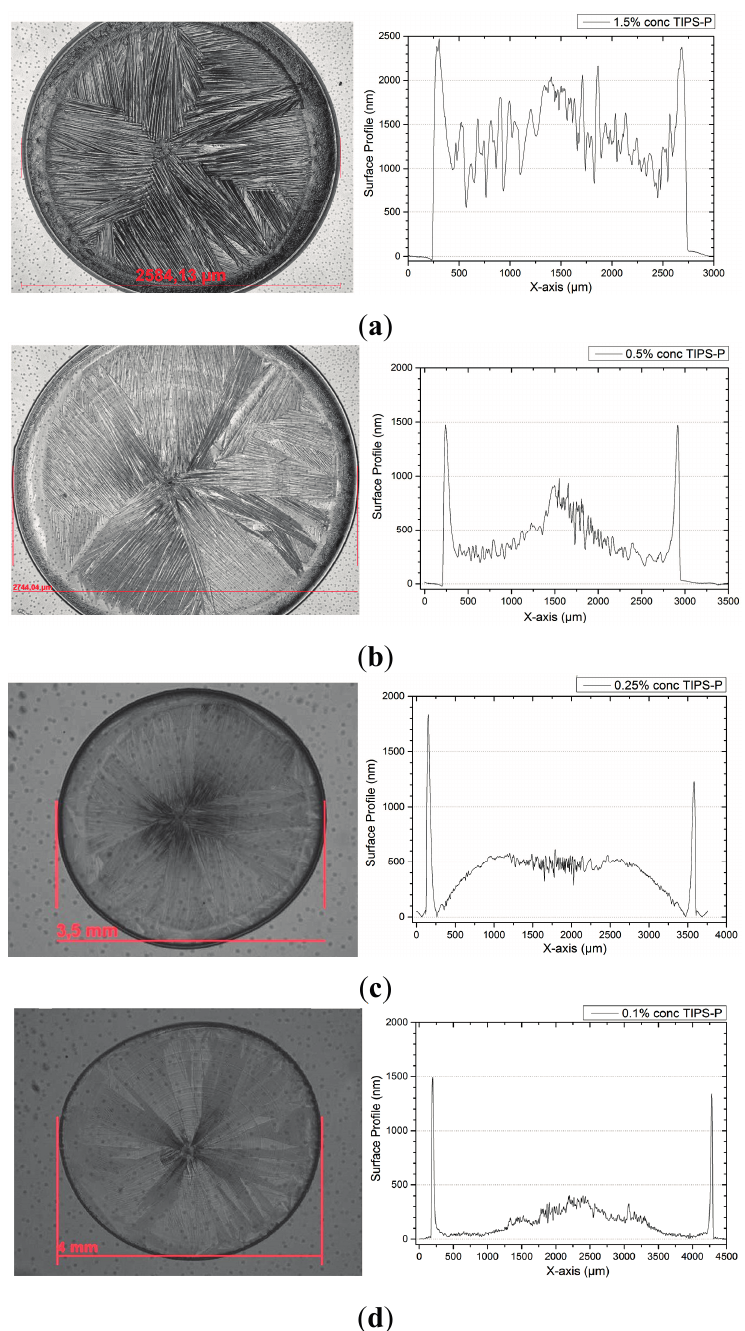
Figure 10. Microscope images of the drops and their corresponding profilometry results with the conc. of TIPS-pentacene varying from ( a ) 1.5%, ( b ) 0.5%, ( c ) 0.25% and ( d )